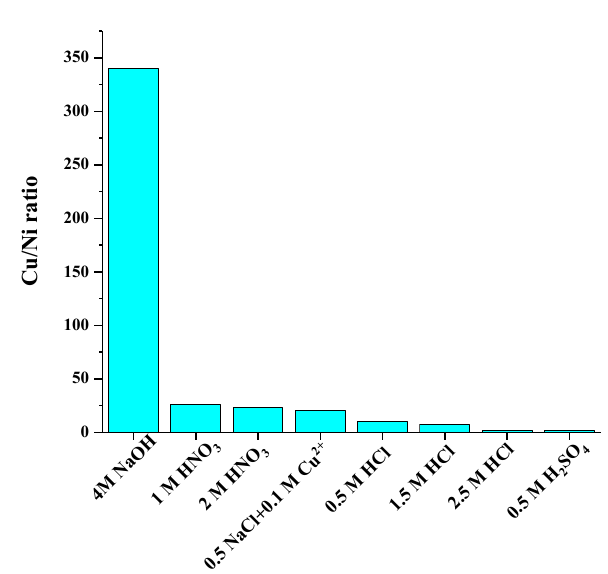
Figure 5. Cu selectivity against Ni in the best eight selective leaching media.